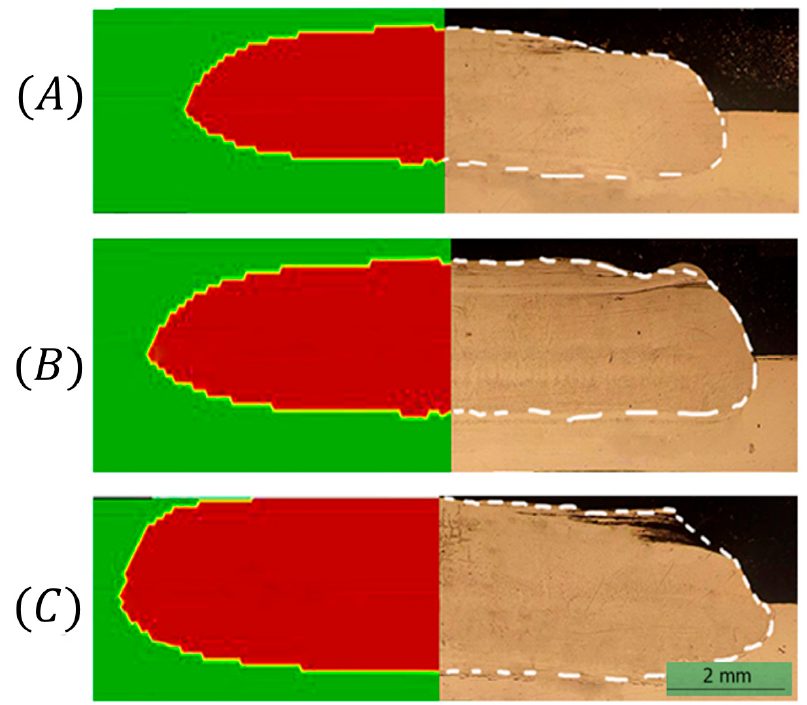
Figure 6. Evaluation of weld nugget simulation results with experimental results ( a ) 1250 A and 0.5 s, ( b ) 2500 A and 1 s, ( c ) 3750 and 1.5 s.